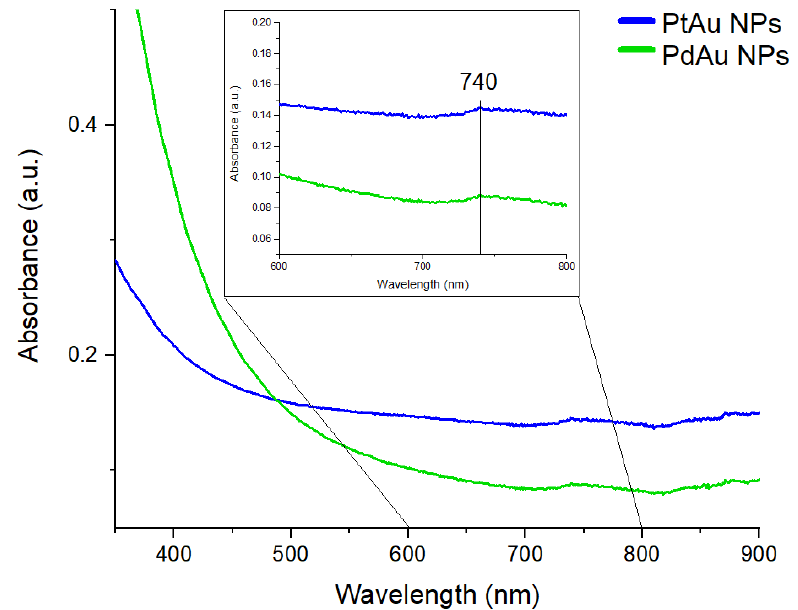
Figure 4. UV-Vis spectra of PtAu NPs (blue curve) and PdAu NPs (green curve).